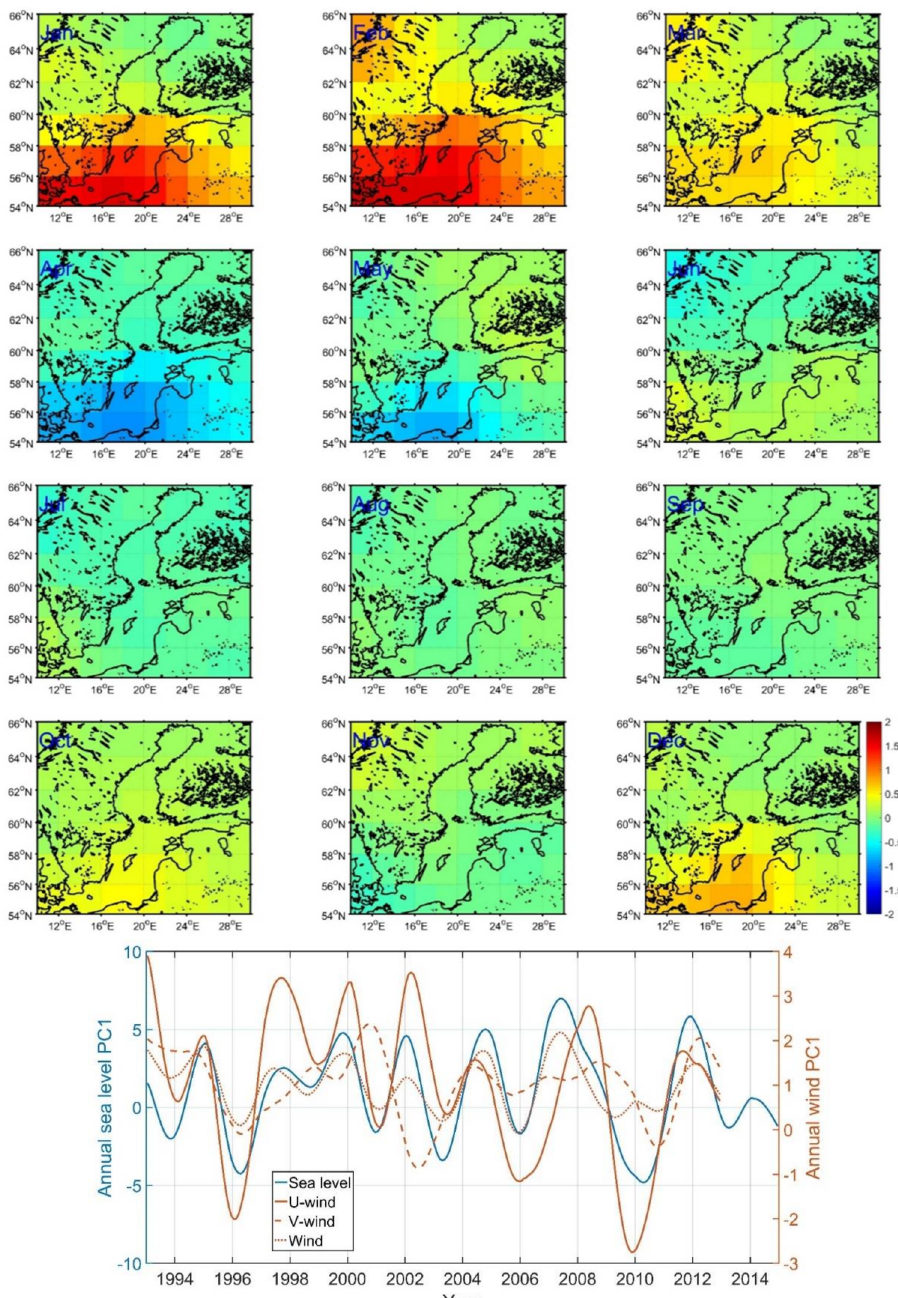
Figure 7. Similar to Figure 4 but for zonal wind speed (m/s). The CSEOF first mode PC time series (PC1, dimensionless) of sea level (blue line), zonal wind speed (orange solid line), meridional wind speed (orange dashed line) and wind speed (orange dotted line), which denote the interannual variations of the annual cycle in the